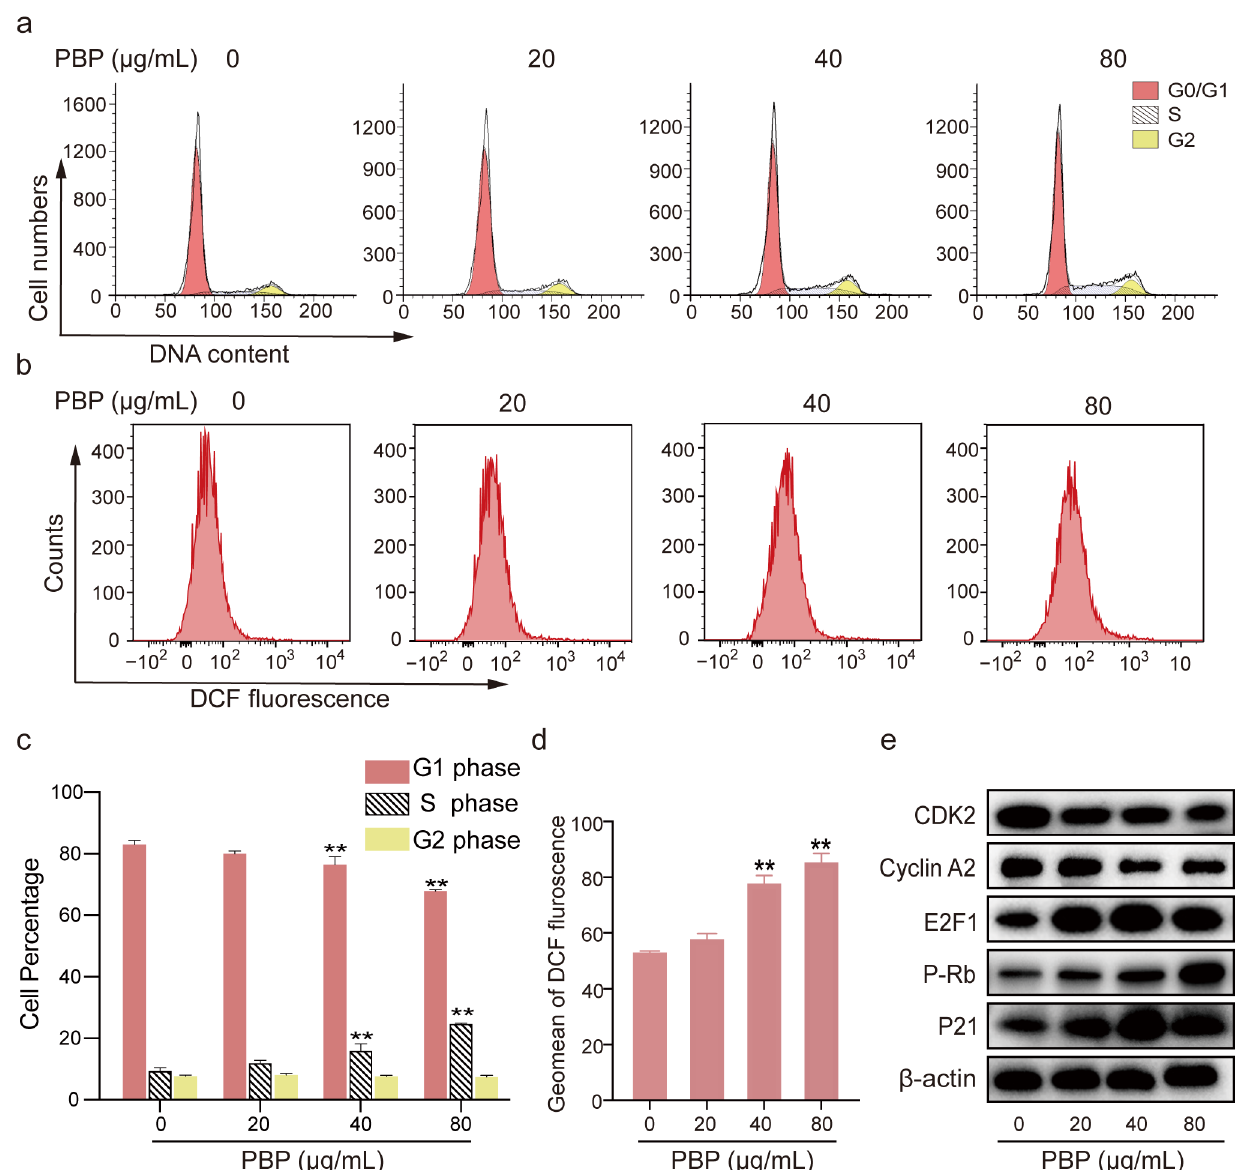
Figure 7. PBP arrested A549 cells in S phase and caused ROS production. ( a ) A549 cells were stained with PI and evaluated using flow cytometry after PBP (0, 20, 40 or 80 μg/mL) treatment for 48 h; ( b ) A549 cells were stained with the ROS indicator (DCF-DA) and analyzed by flow cytometry after PBP treatment for 48 h; ( c ) Analysis quantitative of the cell cycle distribution of A549 cells treated with PBP; ( d ) Quantitative analysis of the DCF fluorescence geomean in A549 cells treated with PBP; ( e ) Western blot analysis of proteins related to S phase arrest. Data are presented as the mean ± SD ( n = 3) by One-way ANOVA analyses. ** p < 0.01 versus control (0 μg/mL PBP). 2.11. PBP Promoted Reactive Oxygen Species (ROS) Generation in A549